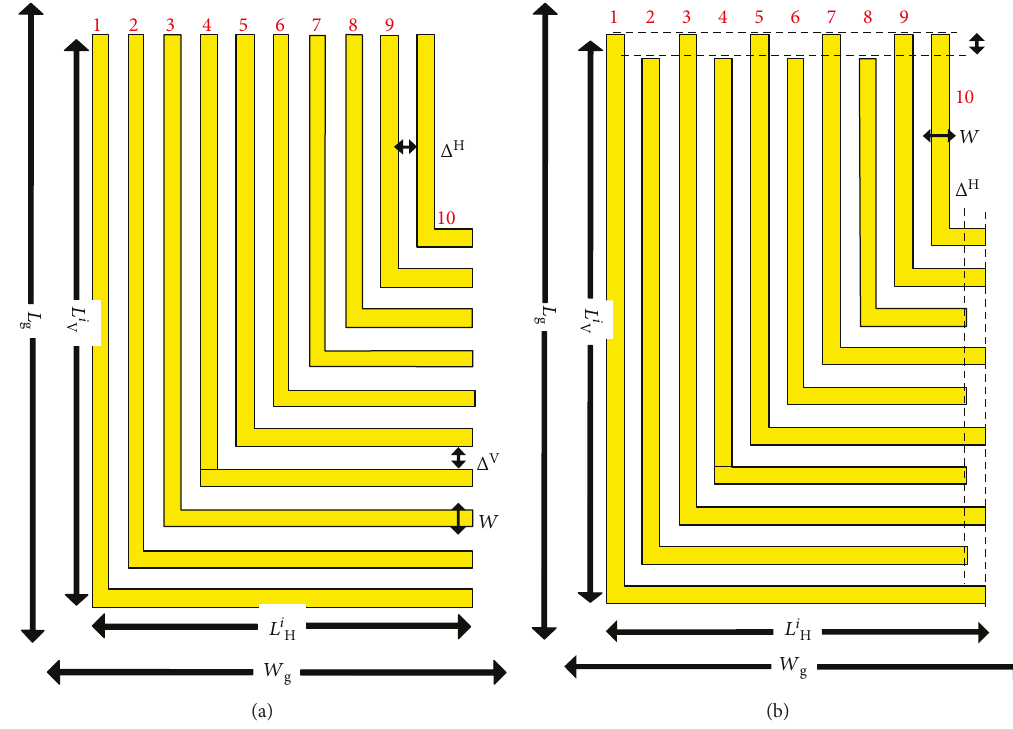
Figure 1: Structure of the proposed L-shaped chipless tag: (a) code 111111111 and (b) code